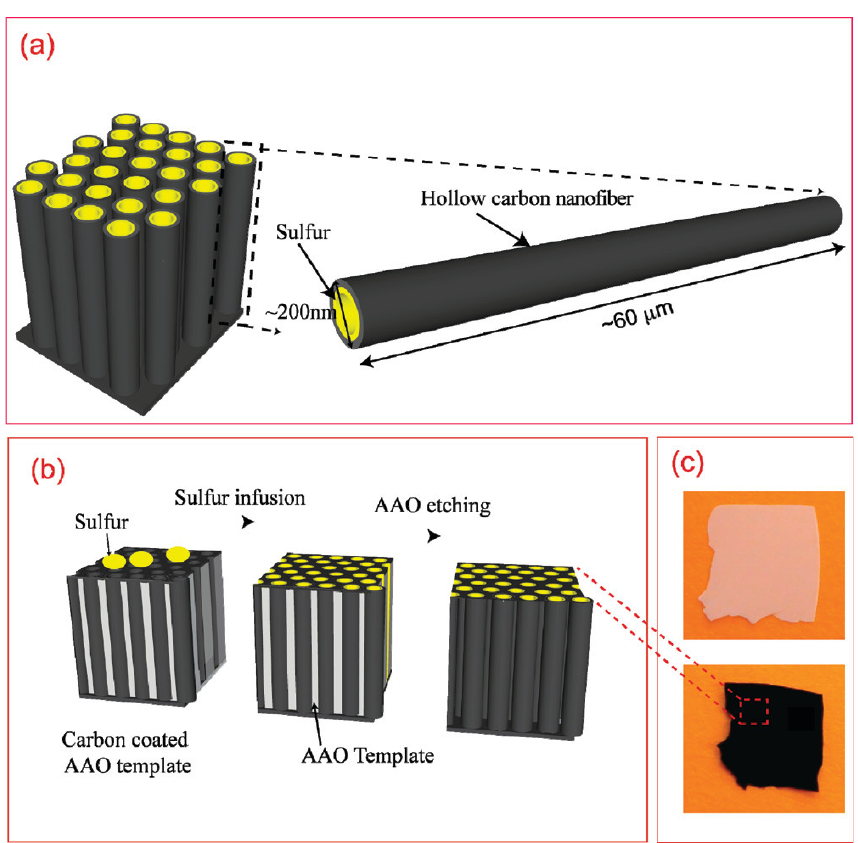
Figure 32. Schematic design and fabrication process of hollow CNFs/sulfur composite structure. ( a ) The design principle shows the high aspect ratio of the hollow carbon nanofiber for effective trapping of polysulfides and ( b ) the fabrication process of carbon/sulfur cathode structure. ( c ) Digital camera images showing the contrast of the PAA template before and after carbon coating and sulfur infusion. Reprinted with permission from Ref. [255]. Copyright © 2023, the American Chemical Society.